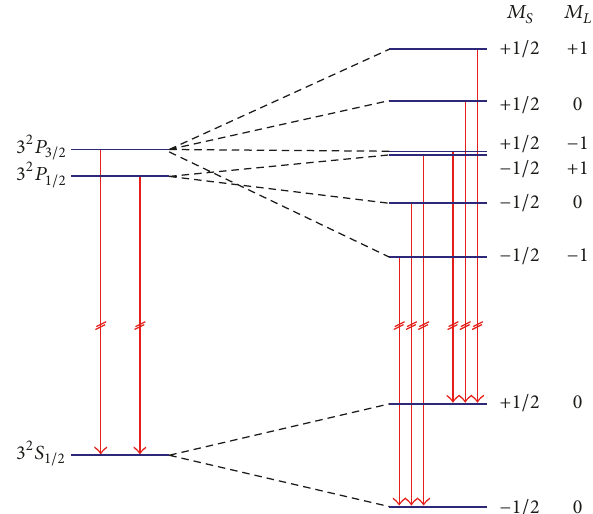
Figure 8: In a strong magnetic field the Na-D-line splits into three spectral lines with Δ𝑀 퐿 = 0, ±1 and Δ𝑀 푆 = 0 .